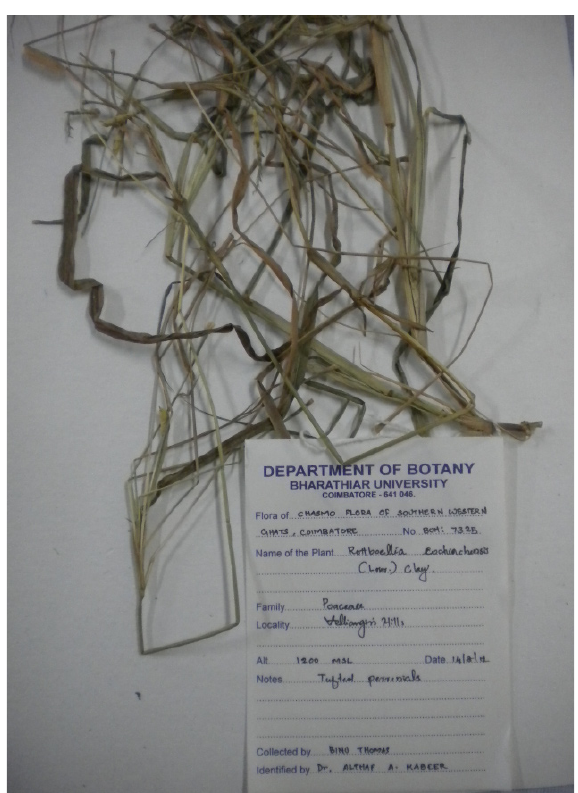
Image 29. Rottboellia cochinchinensis (Lour.) Clayton